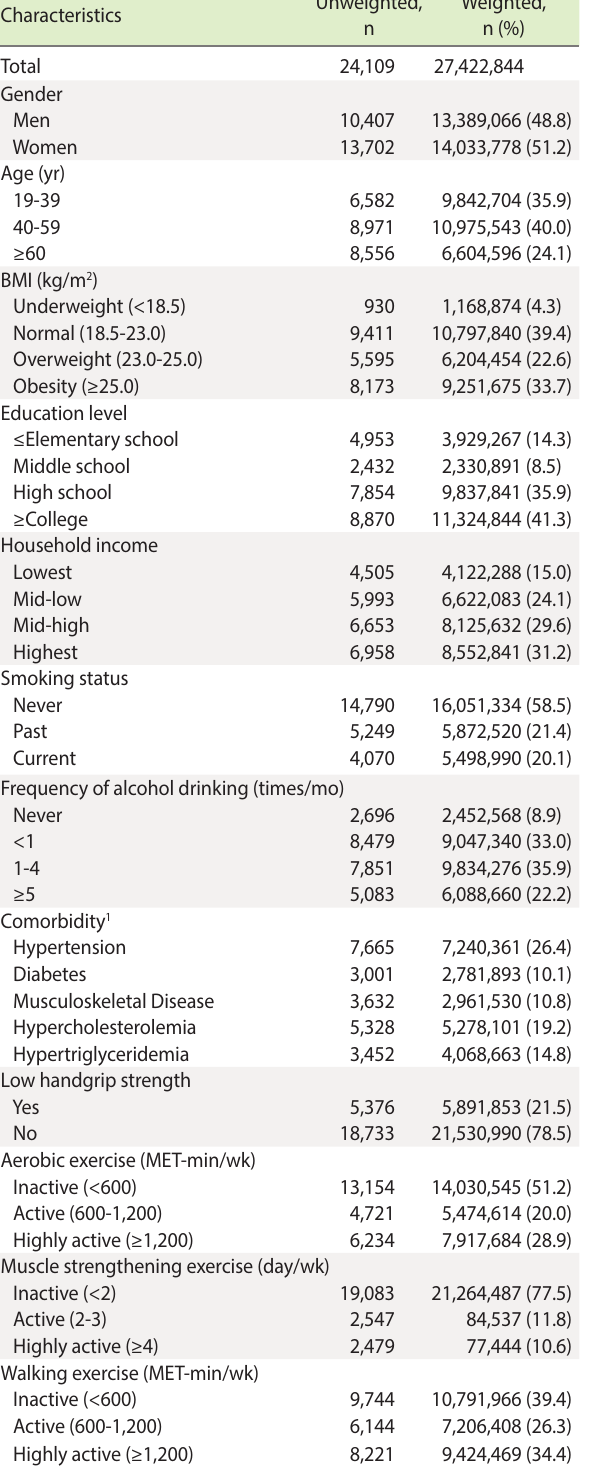
Table 1. General characteristics of the study participants, Korea Na- tional Health and Nutrition Examination Survey